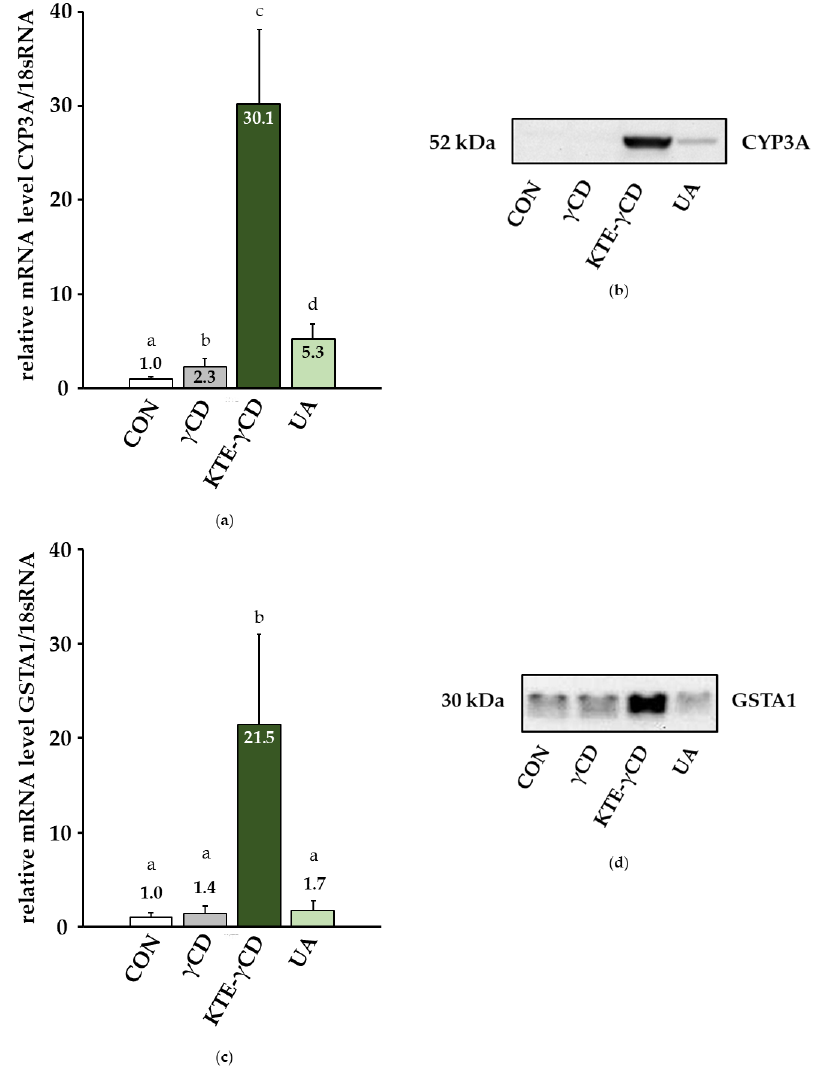
Figure 6. E ff ect of γ -cyclodextrin ( γ CD), Kuding tea extract- γ -cyclodextrin (KTE- γ CD) and ursolic acid (UA) on the phase I and phase II enzymes of xenobiotic transformation in the mouse liver. Mice were fed the following diets ad libitum for 6 weeks: a high-fat, high-fructose, Western-type diet (CON, control), 12.88% γ CD, 7.12% KTE encapsulated in 12.88% γ CD (KTE- γ CD) or 0.15% UA. Gene expression levels of cytochrome P450, family 3, subfamily a (CYP3A) ( a ) and glutathione S-transferase, alpha 1 (GSTA1) ( c ) were analysed via one-step quantitative reverse transcription real-time polymerase chain reaction (one-step qRT-PCR). All qRT-PCR data were normalized to 18sRNA gene expression and are expressed in relation to the CON group. Data are given as the mean + SD ( n = 7–10 mice / diet). Statistical analyses of CYP3A and GSTA1 mRNA levels were performed using the Mann–Whitney U test. Di ff erent letters indicate statistically significant di ff erences between treatments ( p ≤ 0.05). Hepatic protein levels of CYP3A ( b ) and GSTA1 ( d ) were determined by Western blotting, and a representative blot is shown. Representative bands from the stain-free UV image are shown in Supplementary Figures S1 (CYP3A) and S2